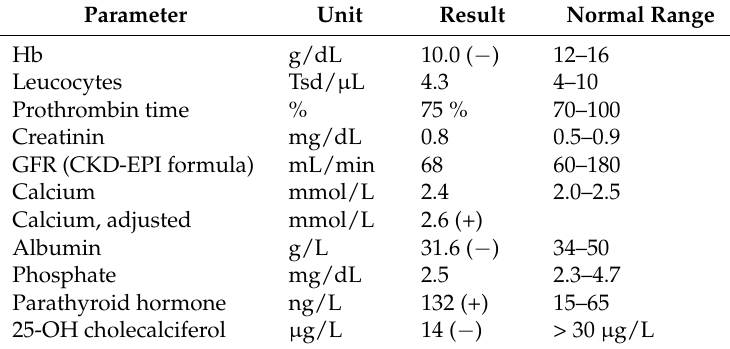
Table 1. Blood results.